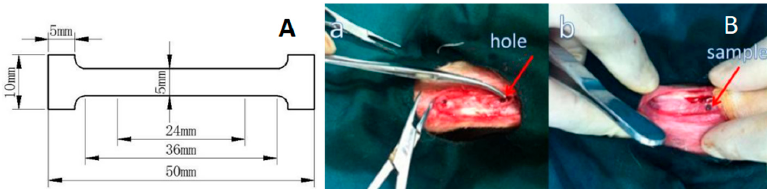
Figure 1. Tensile sample ( A ) and images of PLLA and PLLA1 rods ( B ( a )) before and ( B ( b )) after implantation in rabbit femur condyles.